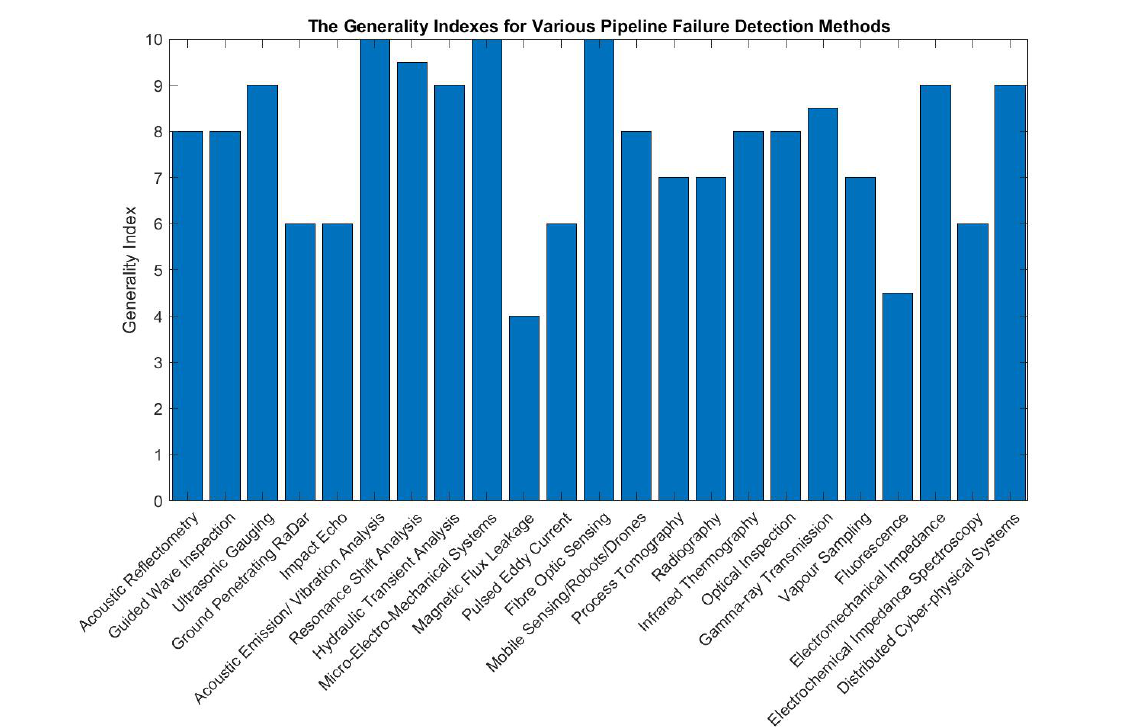
Figure 65. The generality indexes for various pipeline failure detection